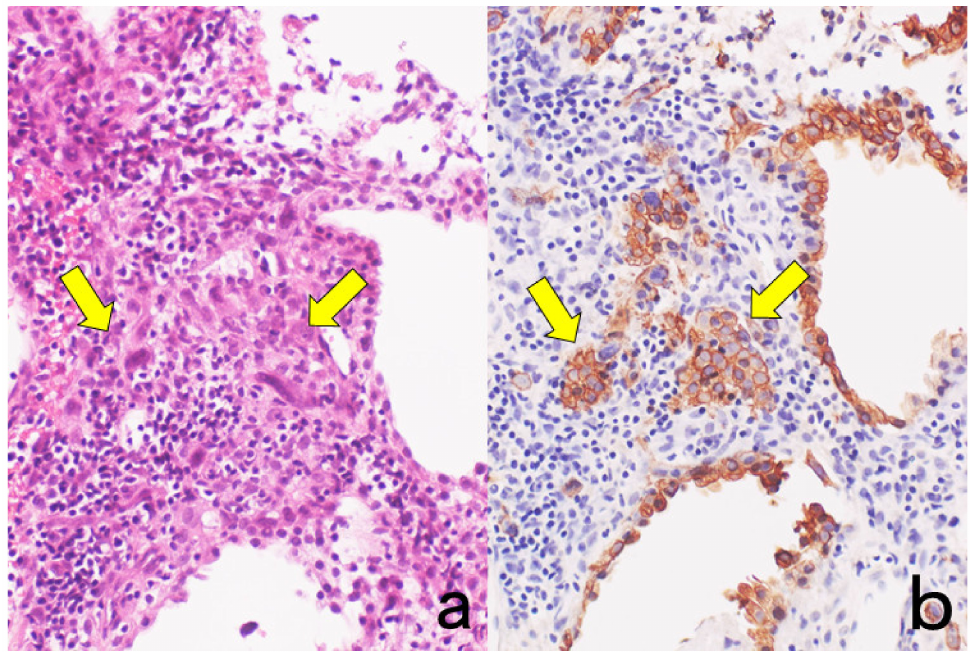
Figure 1. Cytokeratin for identifying intermediate trophoblasts in the placenta. ( a ): H&E, ( b ): cy- tokeratin immunostaining. Intermediate trophoblasts (arrows) are observed in the stroma of the placental tissue sampled by curettage. Cytokeratin immunoreactivity with a monoclonal antibody CAM5.2 clearly illustrates their